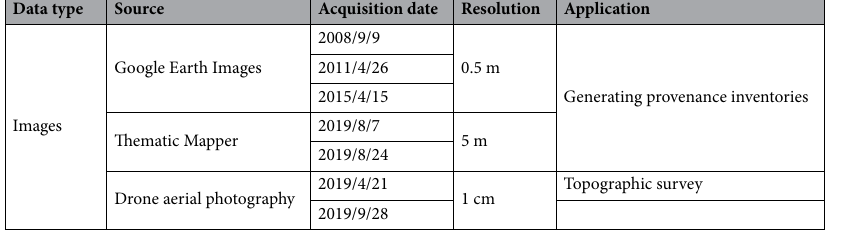
between September 28 and April 21, 2019 was obtained by using the spatial analysis function of ArcGIS; these differences can reflect the topographic changes that occurred before and after the "8.20" debris flow (Fig. 4d). The data showed that the "8.20" debris flow was mainly eroded from the middle and lower reaches of the chan- nel, with an average erosion depth of 1.66 m, a total erosion depth of 1.64 × 10 4 m 3 and a total erosion amount of 39.59 × 10 4 m 3 (Fig. 4d). A large number of large-scale landslides and tributary debris fans on both sides of the main channel provided abundant loose material replenishment for the “8.20” debris flow, increasing the scour- ing force of the debris flow; thus, the drainage canal located before the No. 1 dam was completely destroyed. Debris flows were mainly deposited in the gully mouth of the gully, and a total volume of 63.83 × 10 4 m 3 was deposited compared with the terrain surveyed on April 21, 2019; this number represents the accumulation amount of the "8.20" debris flow. As a large number of deposits congested the river, the riverbed of the Minjiang River was uplifted, and the river surface increased by 3.5 m on average before the outbreak. Multi-temporal source materials inventories. Determining the provenance is the basic condition for studies of debris flows. Therefore, the key to determining the cause of a debris flow is to thoroughly determine the evolution law and migration form of the provenance of the associated debris. Based on this concern, a digital stereoscopic image interpretation was used to map the source material inventories (Table 2, Fig. 5). A resolution of 0.8 m on September 9, 2005, was used to reflect the source material conditions before the earthquake. Two Thematic Mapper (TM) satellite images with 30-m resolutions from the website of the US Geological Survey were used to analyse and compare the formation conditions of debris flows before and after the debris flow broke on 20th Aug 2019. The source materials were classified by their mass movement types 13 (Fig. 6). We differentiated the follow- ing mass movement types: fall, slide, flow, fall-slide, slide-flow, and slide-fall. In the case of fall, materials fall from steep cliffs, with little additional displacement. Bedrock can be seen very clearly in the scarp area, and the accumulation area often tends to be cone-shaped. Slide-type movements are characterized by clear back scarps and the identification of a sliding mass that is either transitional or rotational in form. Flow-type movements are